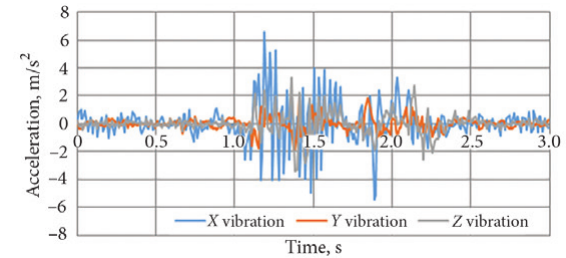
Figure 3. Acceleration over time